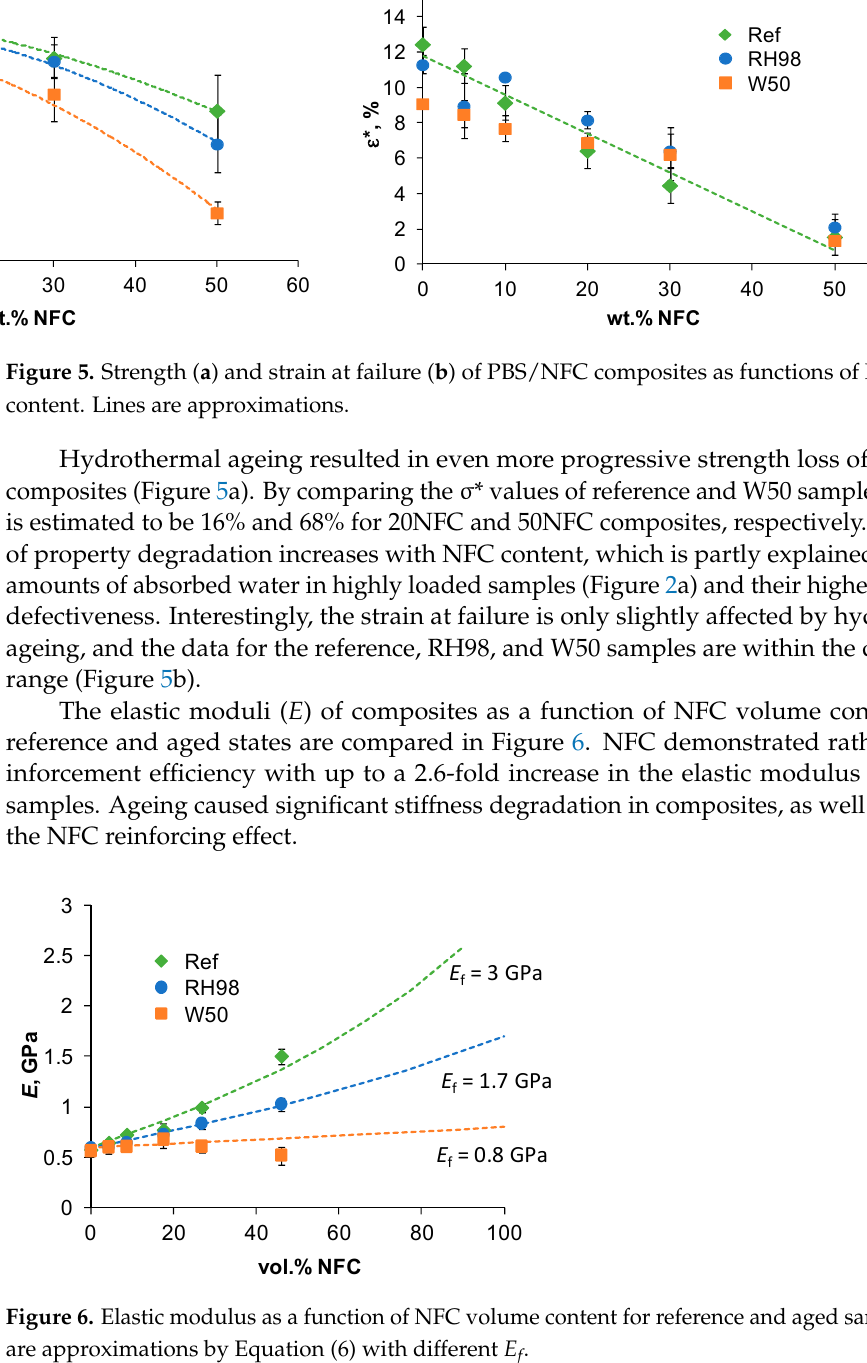
Figure 4. Stress–strain diagrams for reference PBS/NFC composites ( a ) and aged PBS ( b ) and 20NFC ( c ) samples.